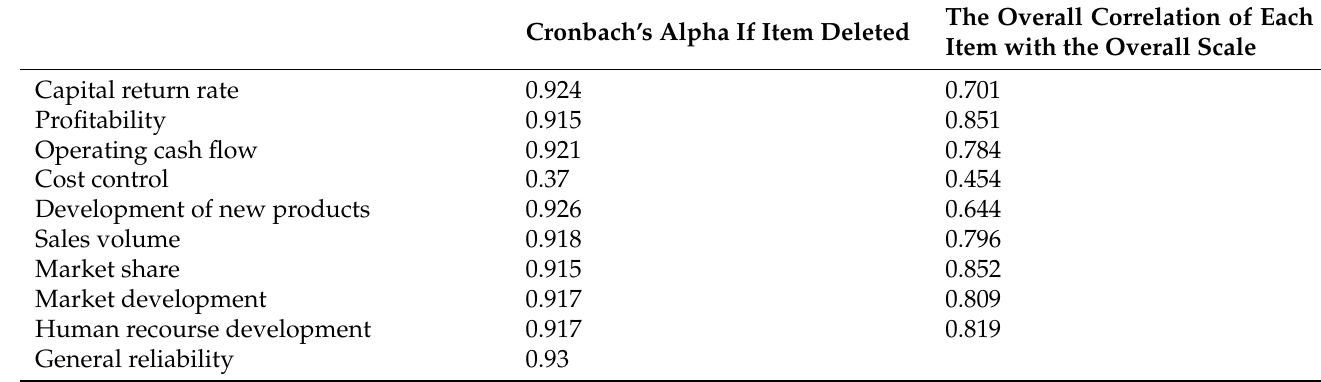
Table 9. Reliability test related to performance measurement.